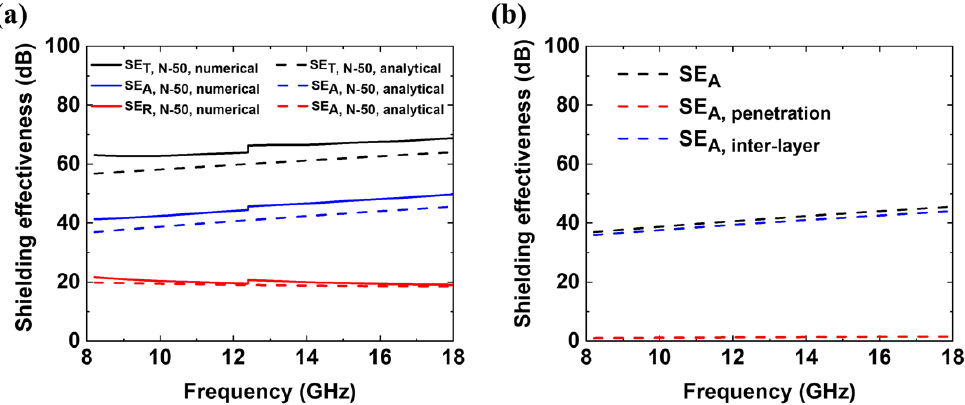
Figure 8. Numerically (continuous line) and analytically (dashed line) calculated shielding effectiveness of N-50 at the X- and K u -bands. ( a ) Numerically and analytically calculated SE T (black), SE A (blue), and SE R (red) of N-50 agree well with each other. ( b ) Analytically calculated total SE A (black), which is composed of the multiple inter-layer reflections (blue) and the penetration loss (red), at the X- and Ku-bands. Most of the total absorption is due to the inter-layer multiple reflections mechanism.